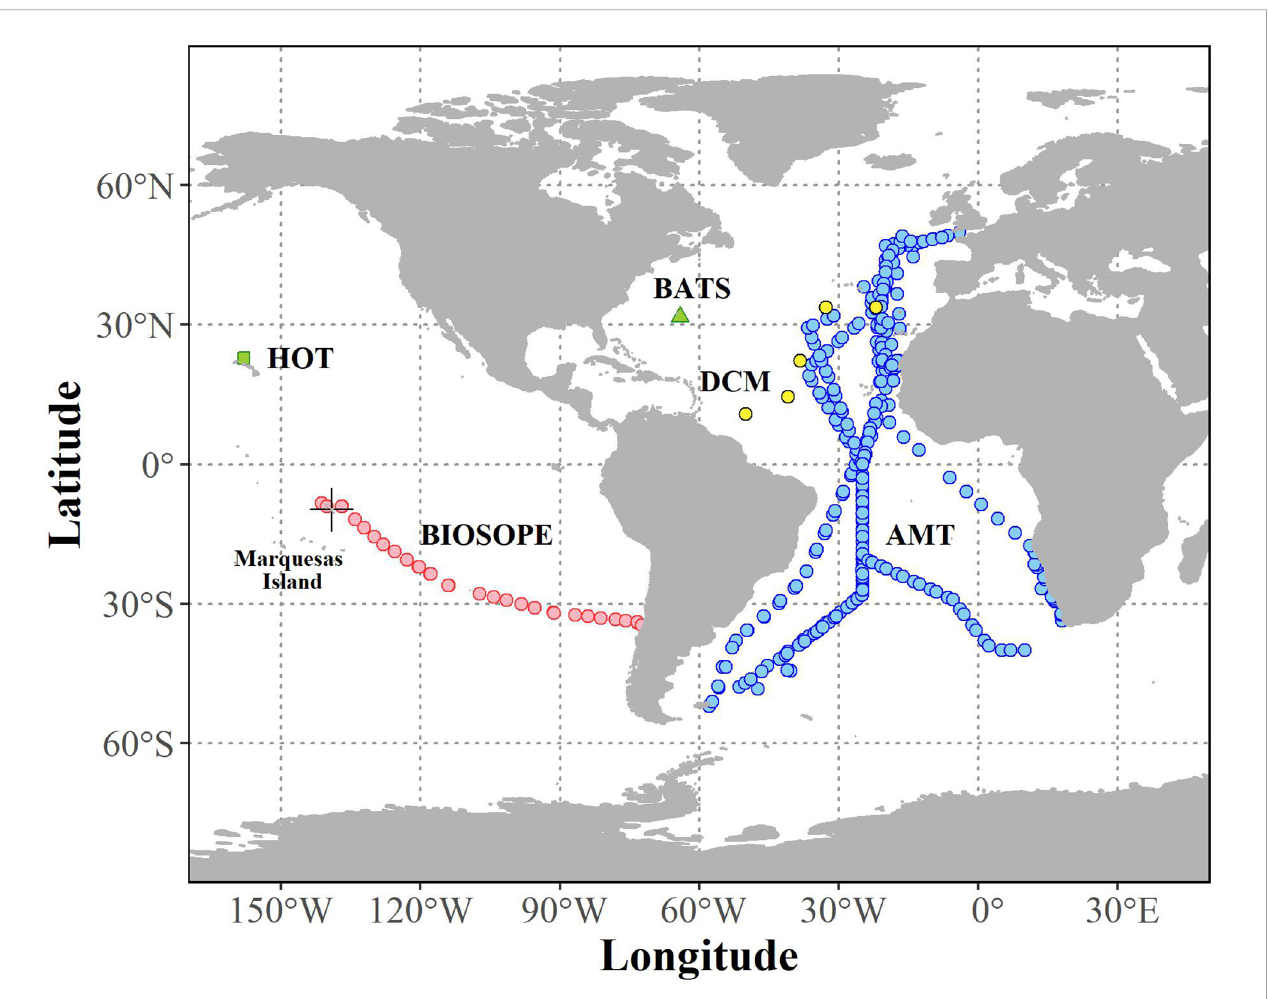
FIGURE 1 Map showing the distribution of oceanographic datasets of simultaneous measurements of phytoplankton pigment and picocyanobacteria abundance that passed quality assurance (N = 1,934).